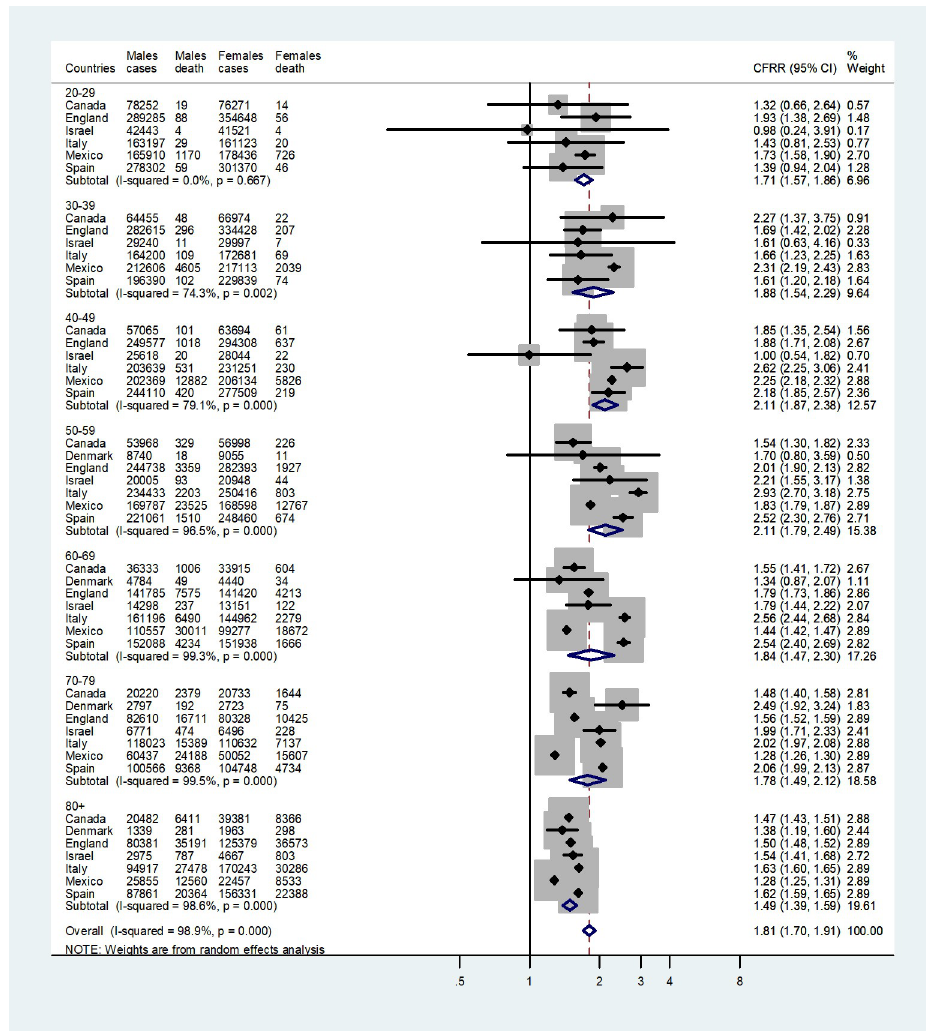
Fig 2. Forest plot of the ratio of the male to female CFRs (CFRR) in seven countries for each age group.